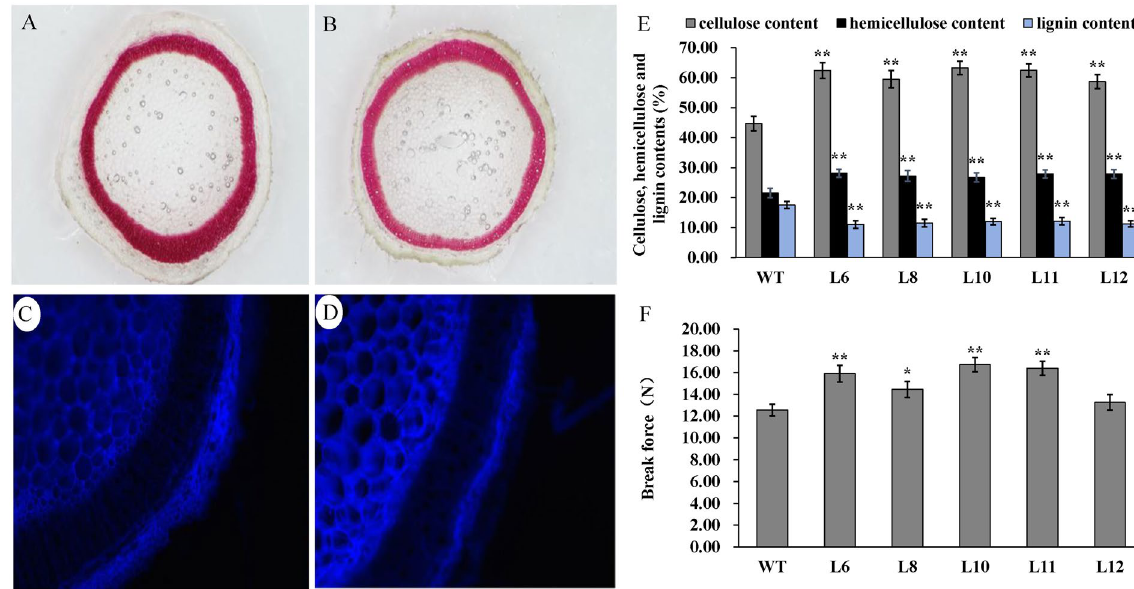
Figure 5. Effects of PsnSHN2 overexpression on the secondary wall deposition and breaking force in the stems of PsnSHN2 transgenic lines. ( A,B ) Phloroglucinol-HCl staining (red color) stem sections of PsnSHN2 transgenic lines ( A ) and wild-type ( B ). ( C,D ) Calcofluor white staining (blue color) stem sections of PsnSHN2 transgenic lines ( C ) and wild-type ( D ). ( E , F ) The contents of cellulose, hemicellulose and lignin ( E ) and the breaking force in stems of PsnSHN2 transgenic lines ( F ). Error bars represent SD of three biological replicates. Asterisks indicate levels of significance ( t test; * P < 0.05, ** P <